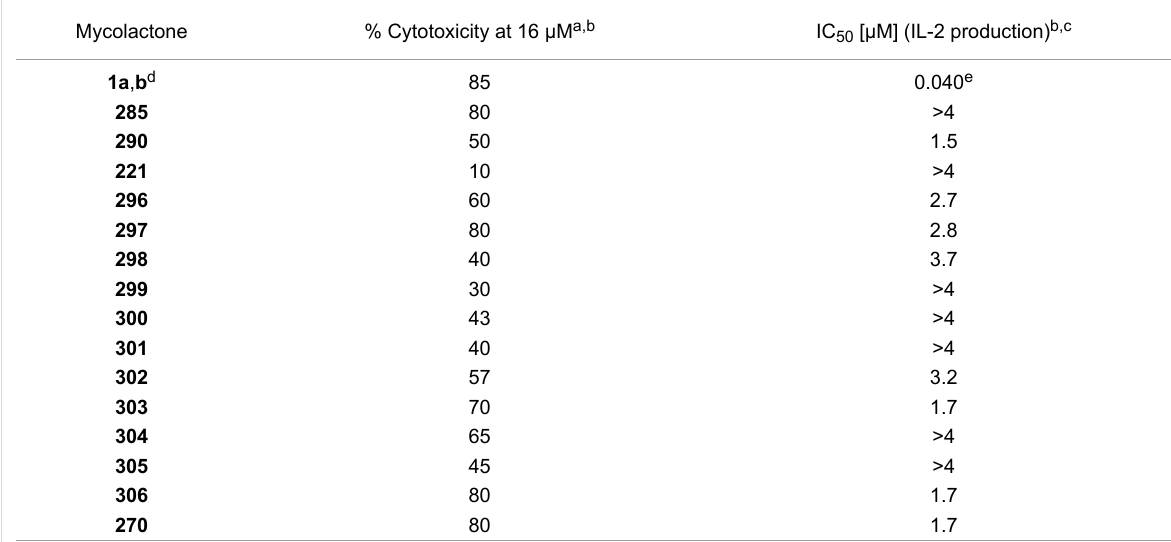
Table 5: Cytotoxicity and immunosuppressive properties of C8-desmethylmycolactones.